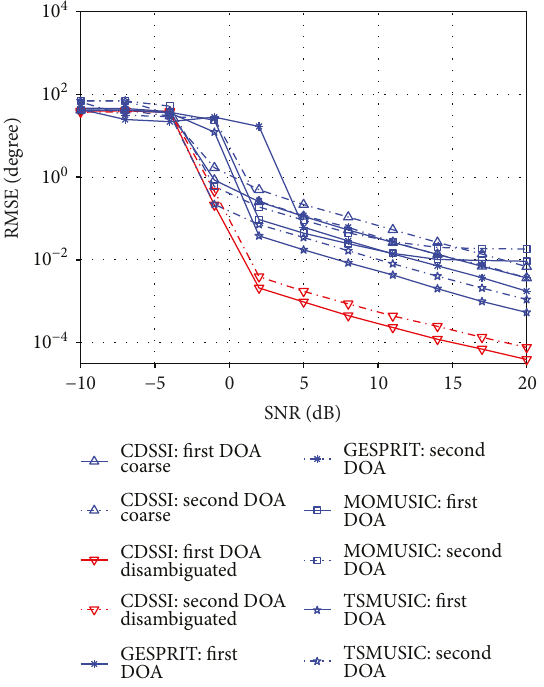
Figure 13: RMSEs of DOA estimates versus